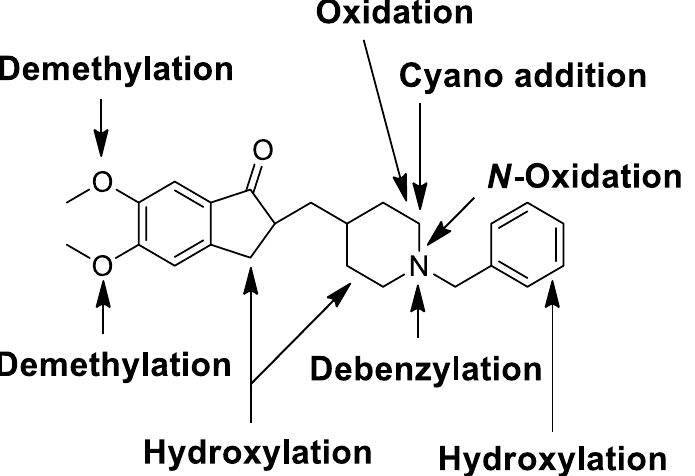
Figure 7. Chemical structure of donepezil showing locations of Phase I metabolic reactions and the bioactivation pathway.